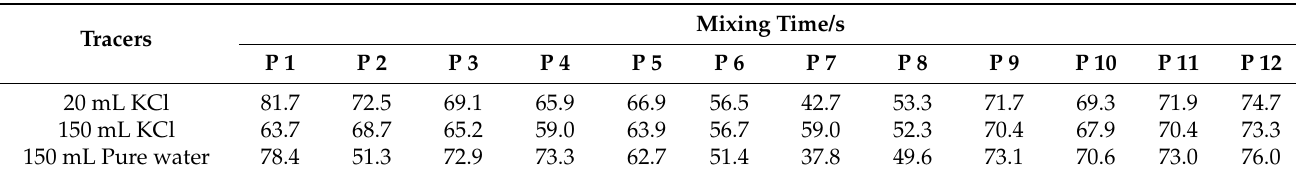
Table 4. Mixing time at all monitor points (Point is abbreviated as